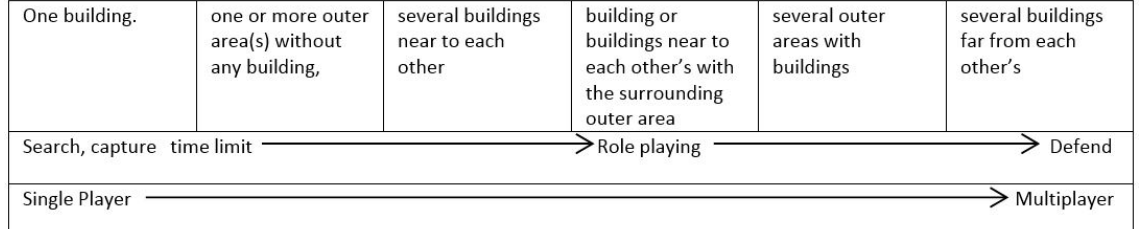
Figure 2. Mapping of game mechanics to site